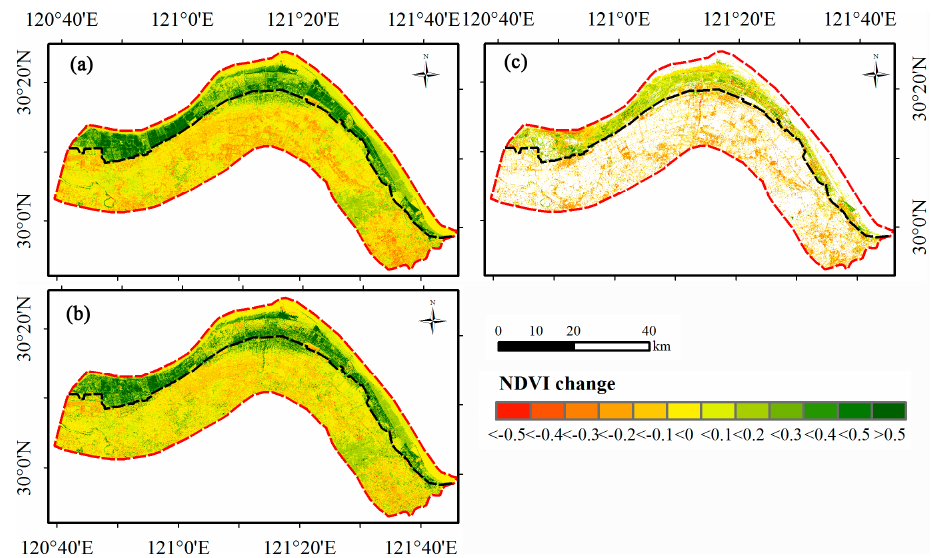
Figure 9. NDVI changes at Hangzhou Bay in Zhejiang Province, China, during 1987–2015. ( a ) total NDVI change; ( b ) gradual NDVI change; ( c ) abrupt NDVI change.